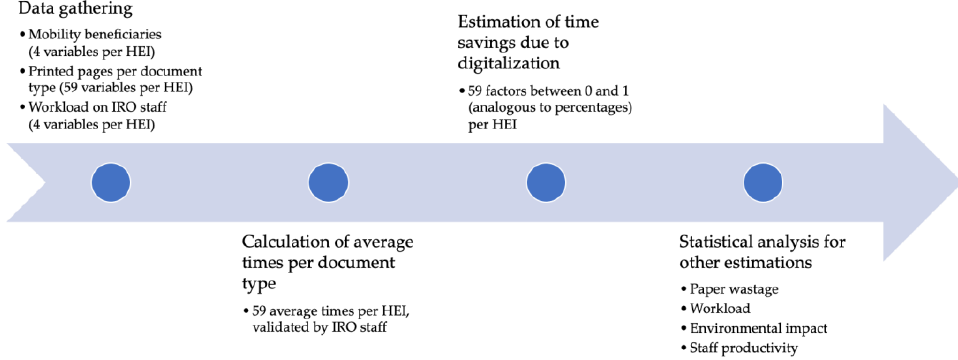
Figure 1. Methodological steps followed in the